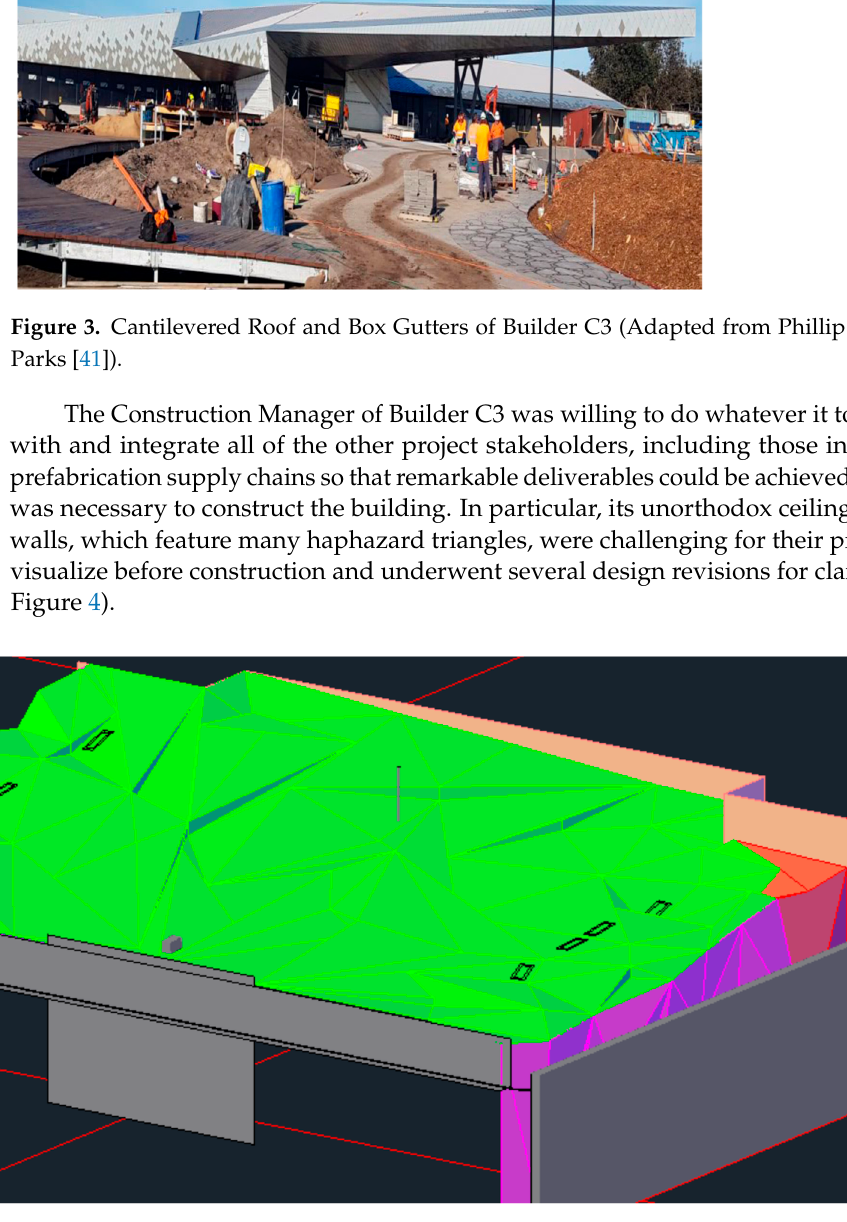
Figure 4. Complex Suspended Ceiling and Internal Walls of Builder C3 (Adapted from Phillip Island Nature Parks [41]).